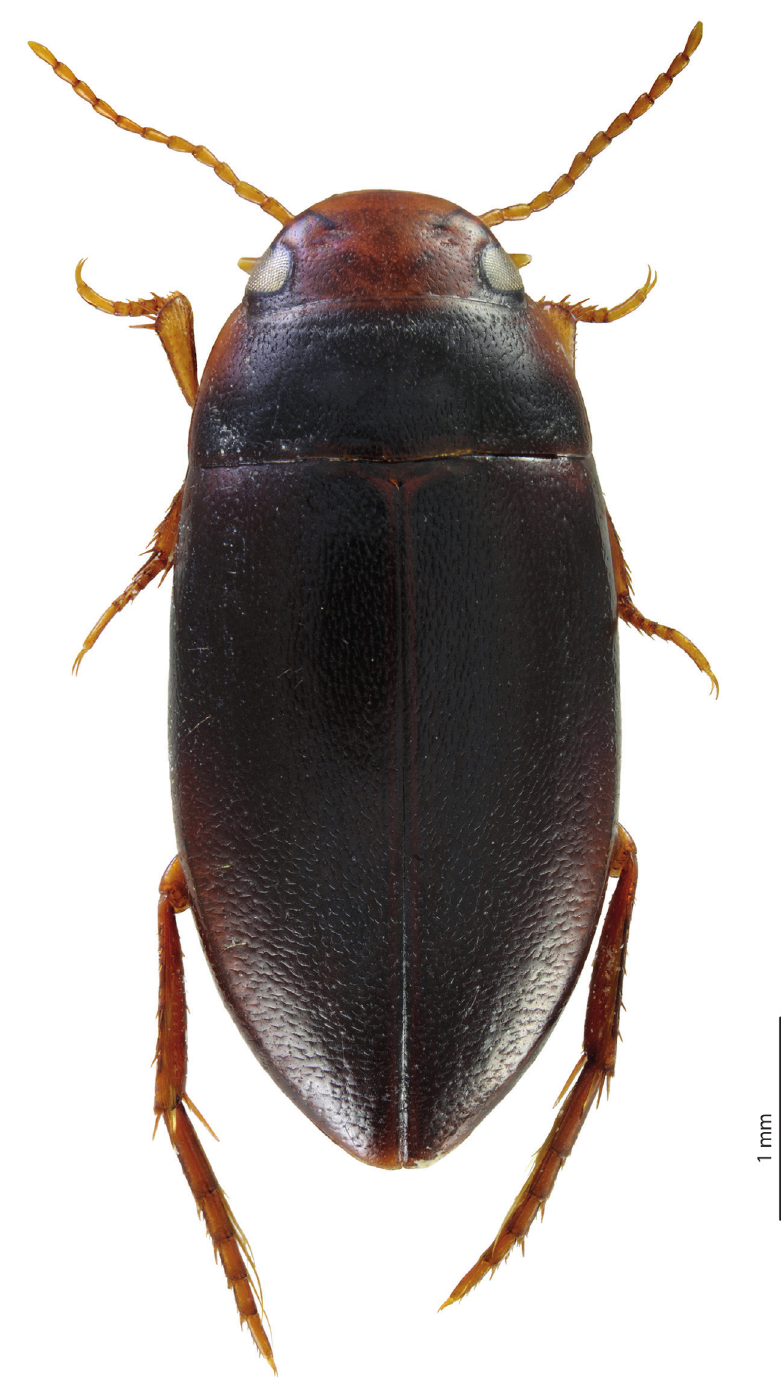
Figure 1. Habitus of Exocelina baliem sp. n.,